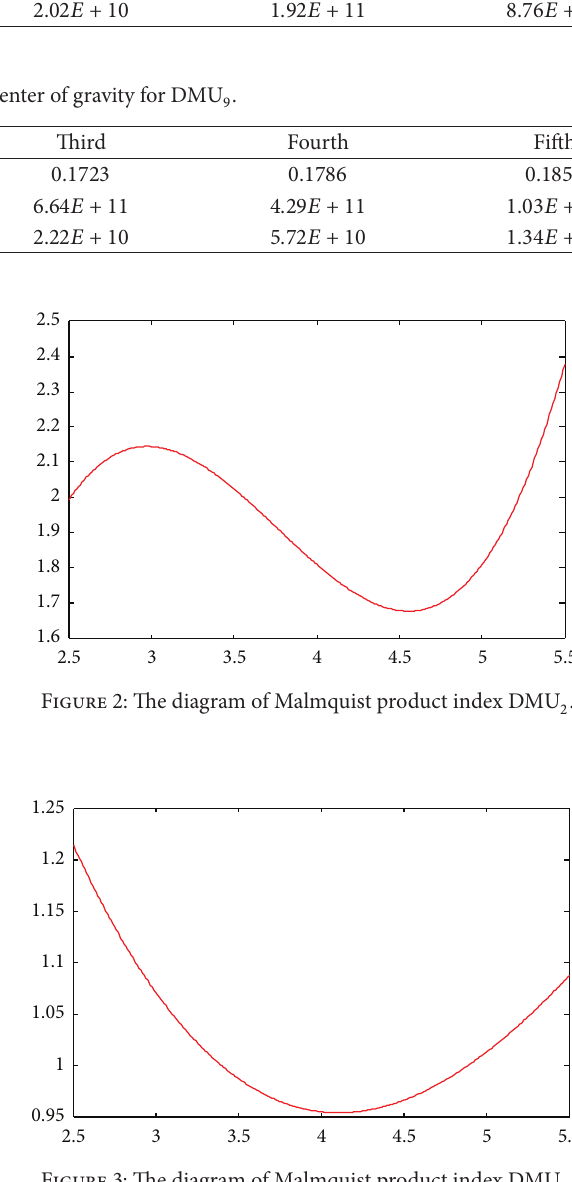
Figure 3: The diagram of Malmquist product index DMU 3